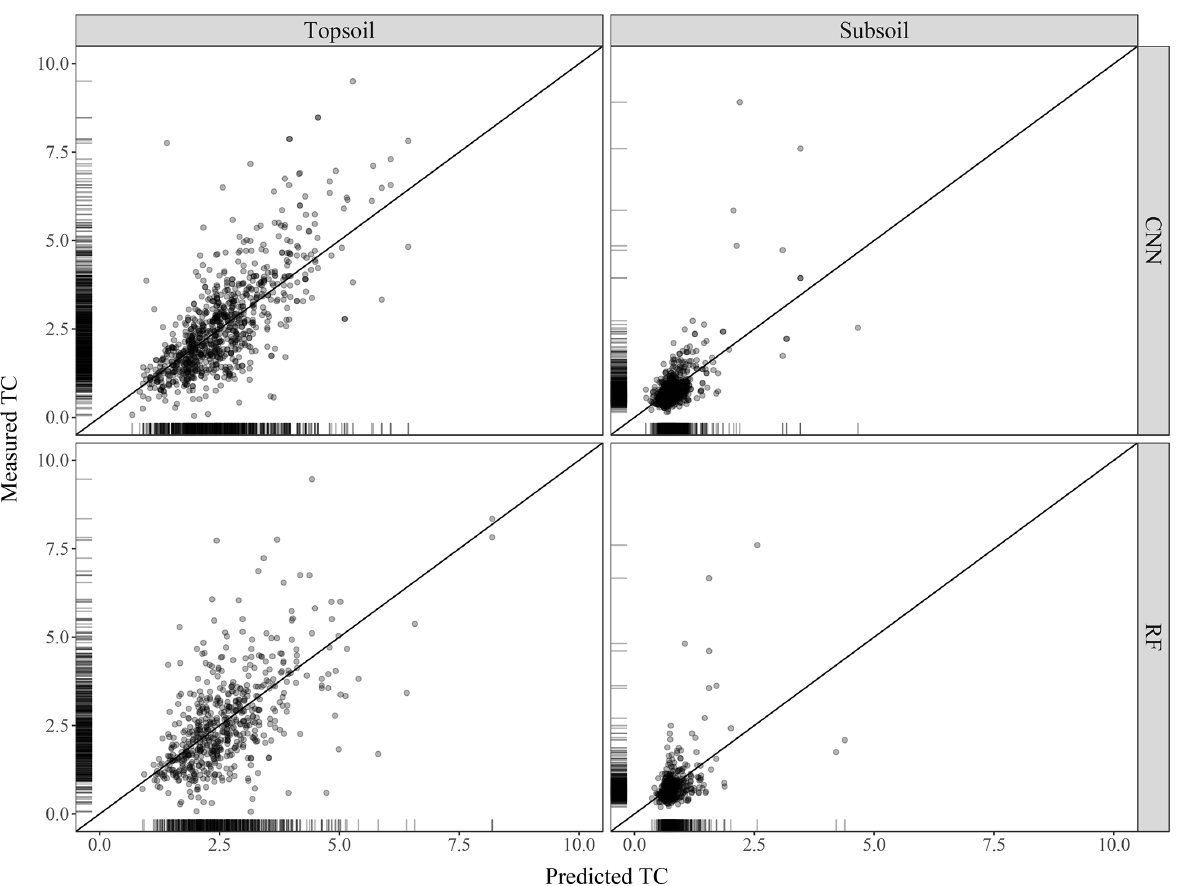
Figure 5. Scatterplot of the measured against predicted topsoil and subsoil TC for the CNN and RF models, along with the 1 : 1 line. Values are expressed in g100g − 1